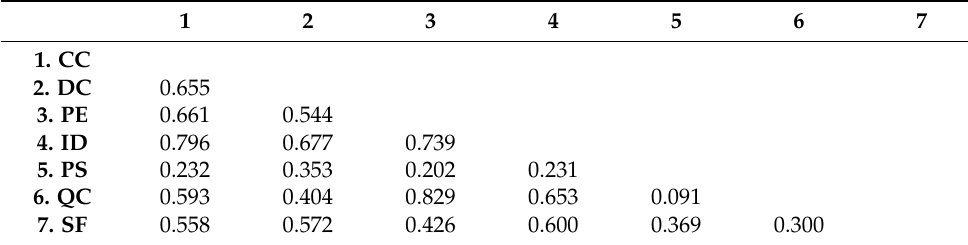
Table 3. Heterotrait–monotrait (HTMT) ratio for the constructs.